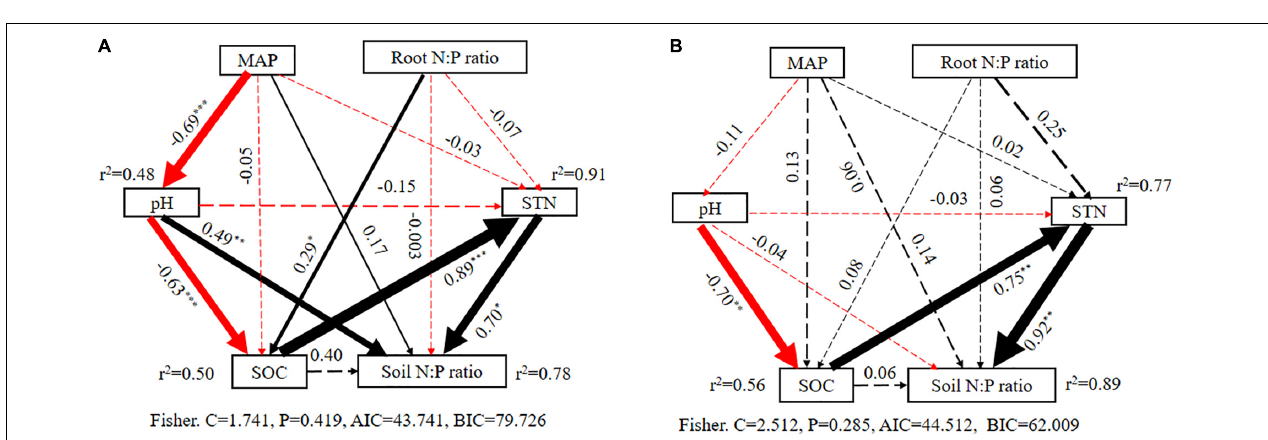
FIGURE 8 | Partial correlations between controlling factors, such as soil properties, plants, mean annual precipitation (MAP), and soil nitrogen (N): phosphorus (P) ratio in alpine shrublands (A) and desert shrublands (B) . Plant factor refers to root N:P ratio. “ ∗ ” indicates a significant difference at the level of P < 0.05.